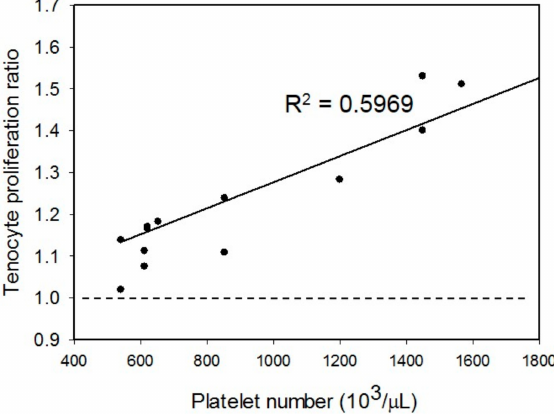
Figure 8. Correlation between the platelet number in the PRP and the tenocyte proliferation ratio. The blood and tissue samples were collected from 8 different patients. The PRP were respectively prepared by A2 and B2 procedures. Each data point represents the result from 1 experiment. Tenocytes are fibroblast-like cells and constitute the cellular component of periarticular tendons. They are responsible for synthesis, production, and maintenance of the extracellular